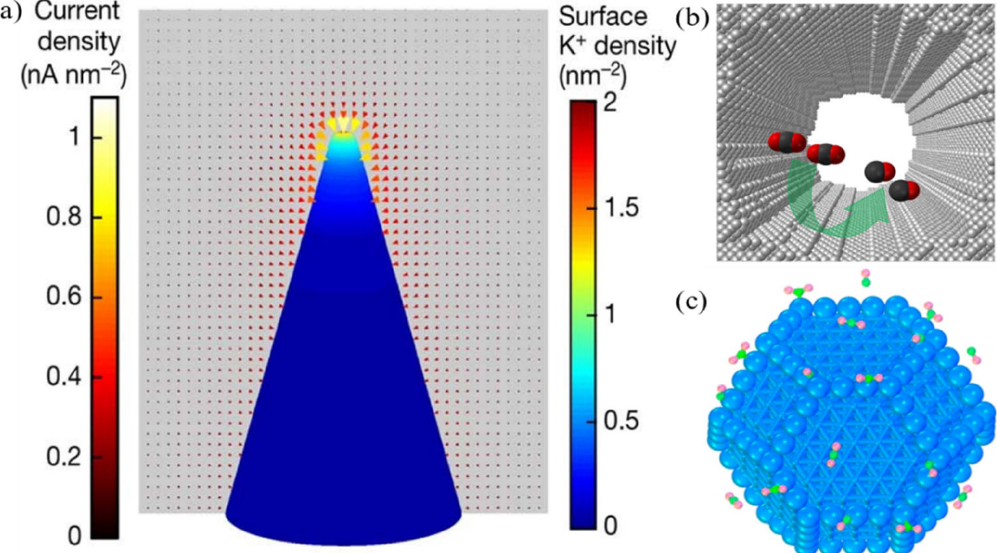
Figure 5. ( a ) K+ density and current density distribution on the surface of a gold nanoneedle with a tip radius of 5 nm [38]. ( b ) Schematic representation of a nanopore for a silver electrocatalyst with a highly curved inner surface [42]. ( c ) Schematic diagram of CO 2 molecules adsorbing on palladium clusters [43].